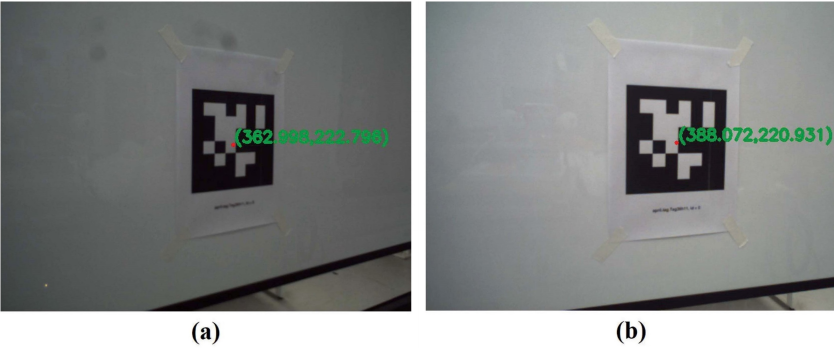
Figure 9. The images of the left and right cameras. ( a ) left image; ( b ) right image.